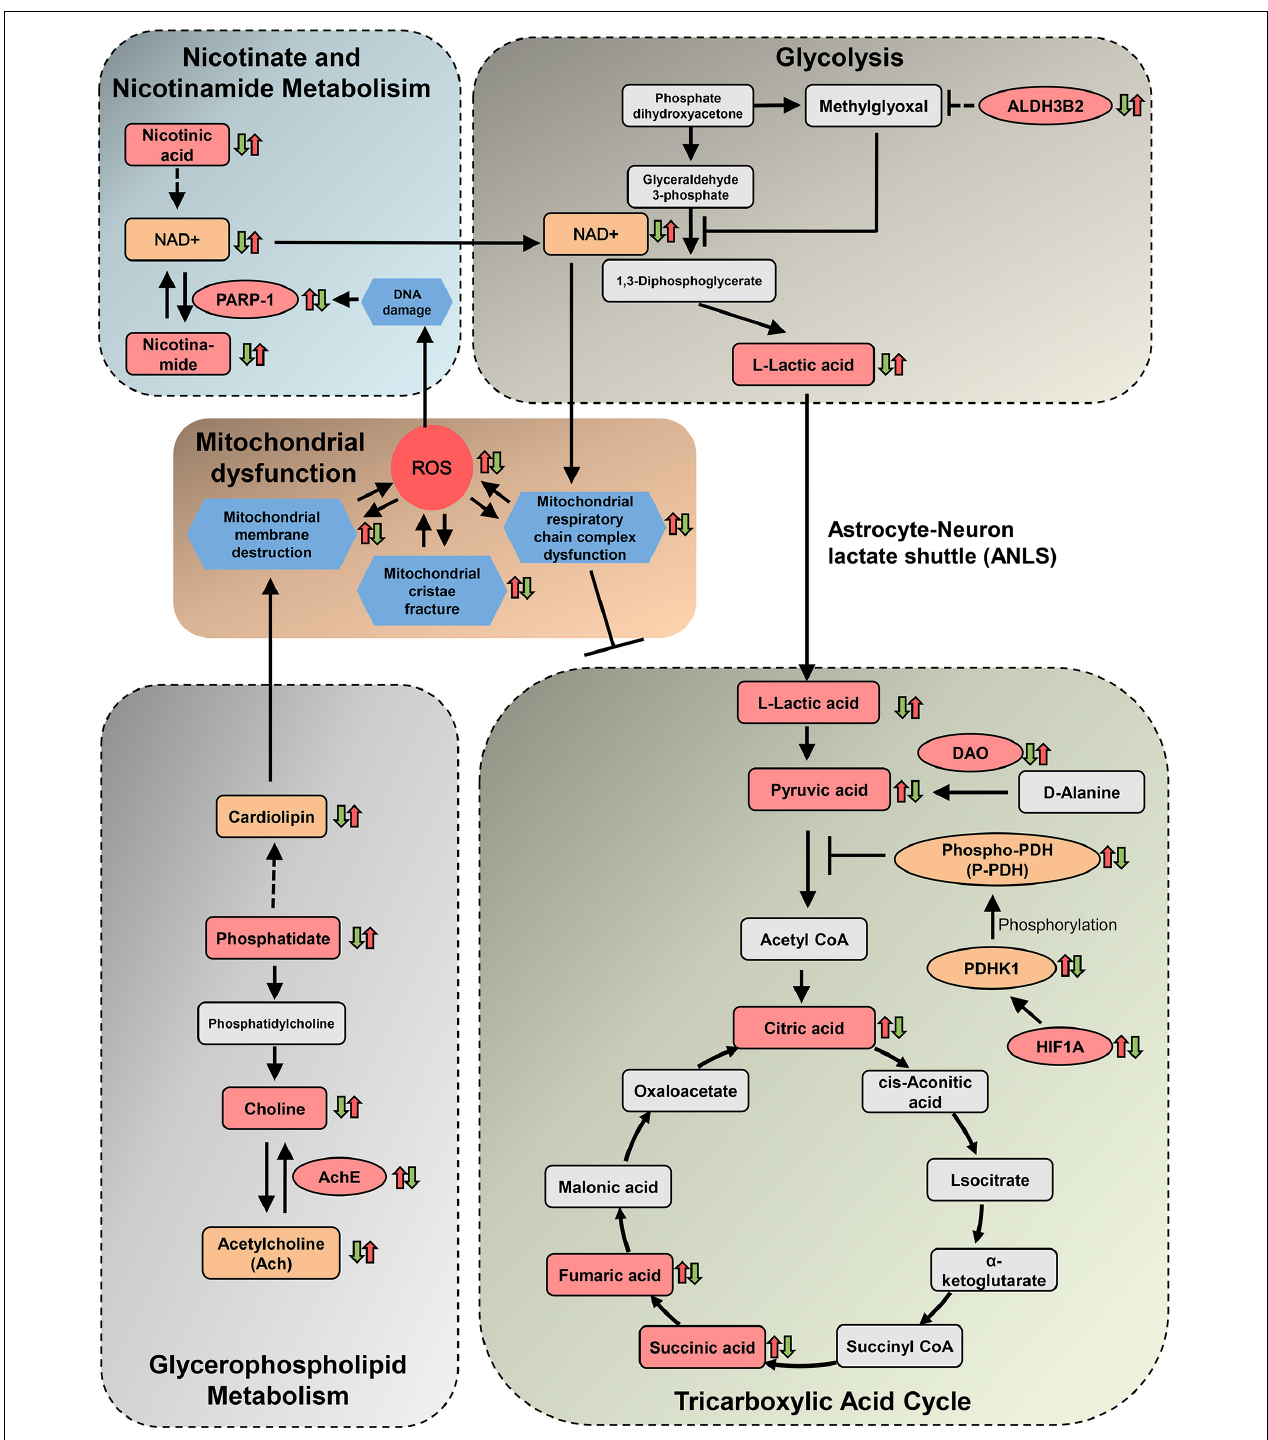
FIGURE 10 | Diagram depicting protective effects of DHYZ on oxidative stress and related metabolism. The squares represent metabolites, the dark pink squares represent urine differential metabolites revealed by metabolomics analysis, the orange squares represent cerebral metabolites confirmed by other experimental verification. The dark pink ellipses represent target proteins of DHYZ against AD, the orange ellipses represent key enzymes regulated by DHYZ. Red up-arrows and green down-arrows indicate up-regulation and down-regulation, respectively. Left arrows represent model vs. control; right arrows represent DHYZ vs. model. NAD + , nicotinamide adenine dinucleotide; PARP-1, Poly [ADP-ribose] polymerase 1; ALDH3B2, aldehyde dehydrogenase 3 family member B2. AchE, acetylcholinesterase; DAO, d-amino-acid oxidase; HIF1A, hypoxia-inducible factor 1-alpha; PDHK1, pyruvate dehydrogenase kinase 1; T-, P-PDH, total, or phosphorylated pyruvate dehydrogenase; ROS, reactive oxygen species.